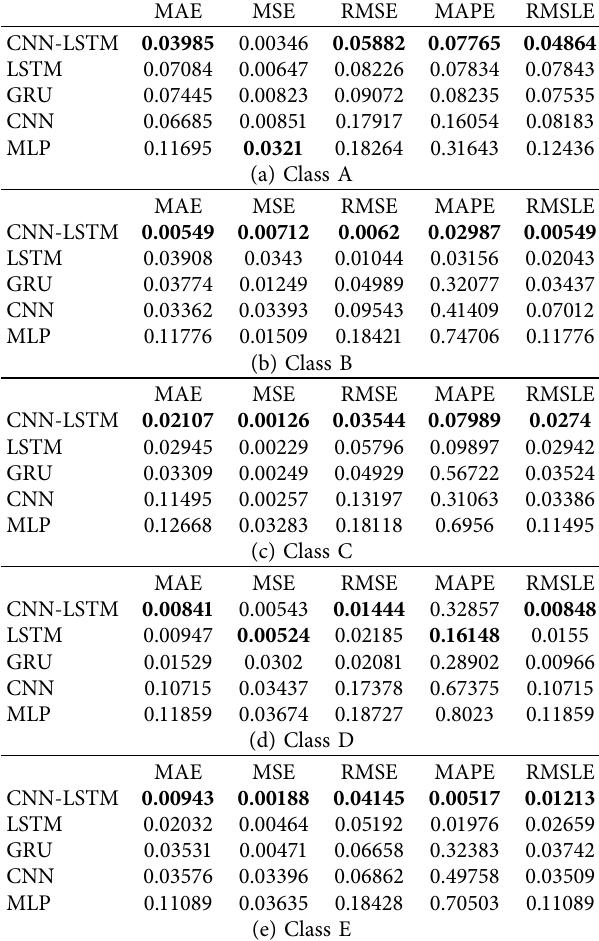
Table 10: Machine learning for historical data with weather data evaluation